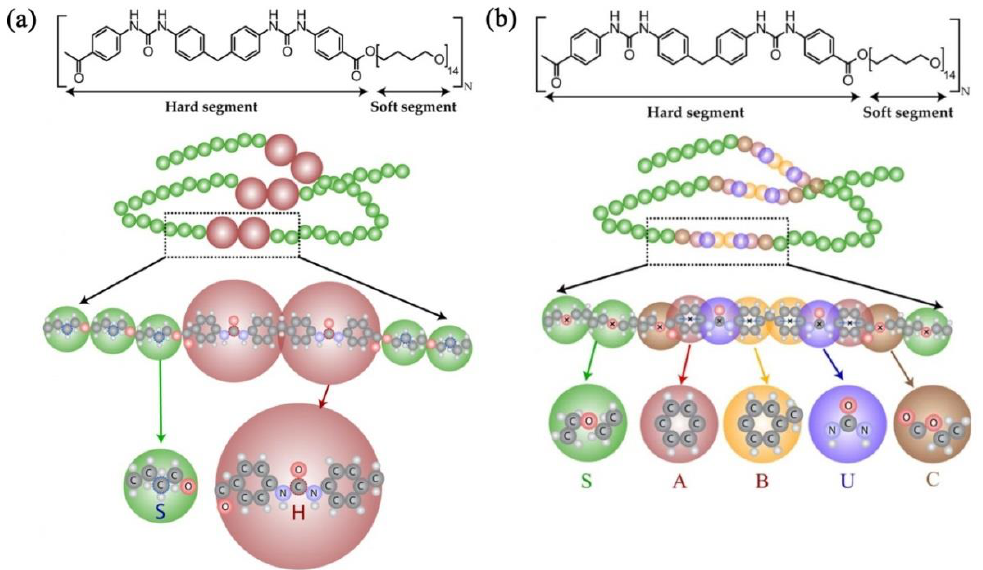
Figure 4. Polyurea CG models: ( a ) two-bead model and ( b ) five-bead model. Reproduced with permission from refs. [58,60].